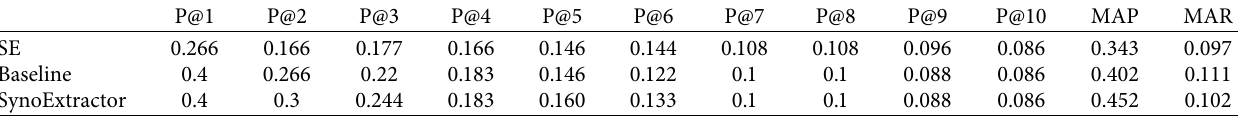
Table 18: Comparison between Sketch Engine and the SynoExtractor pipeline for synonym